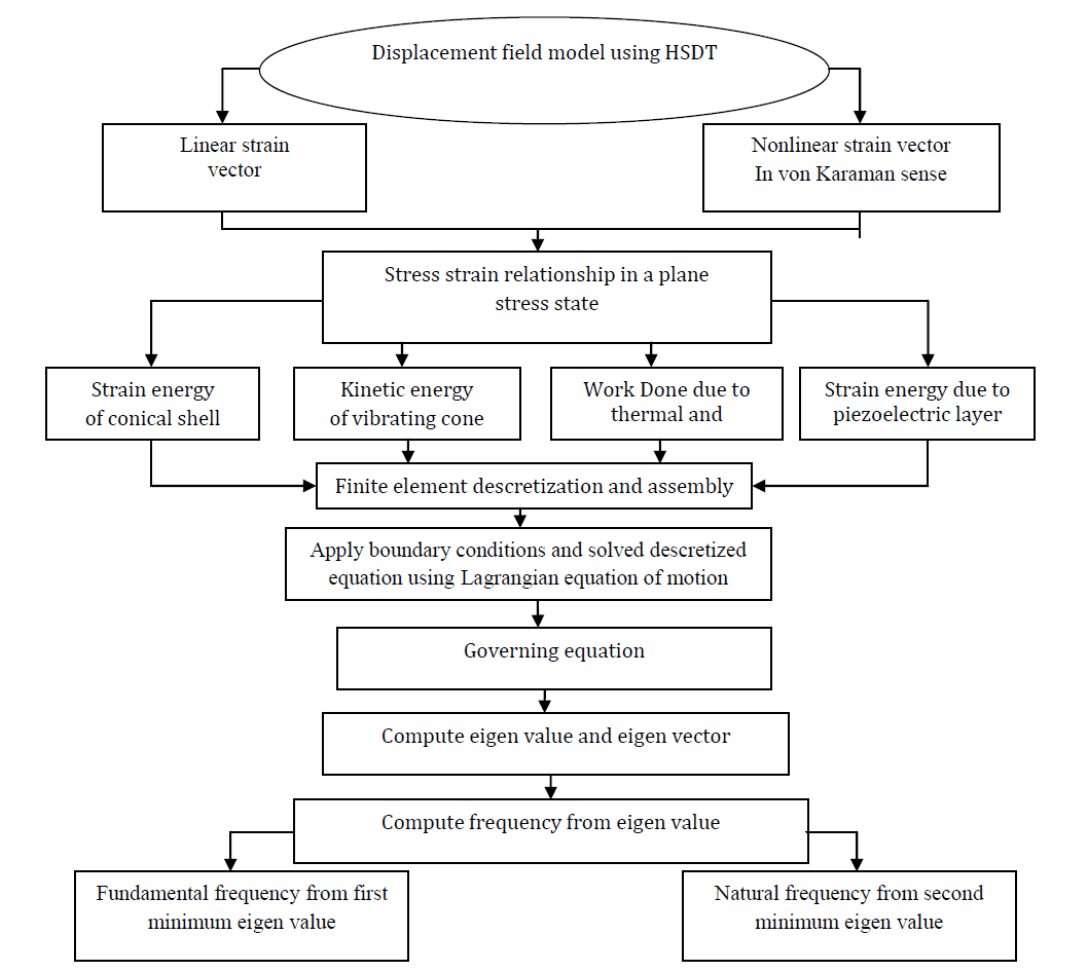
Figure 2: Flow chart for an overview of the present